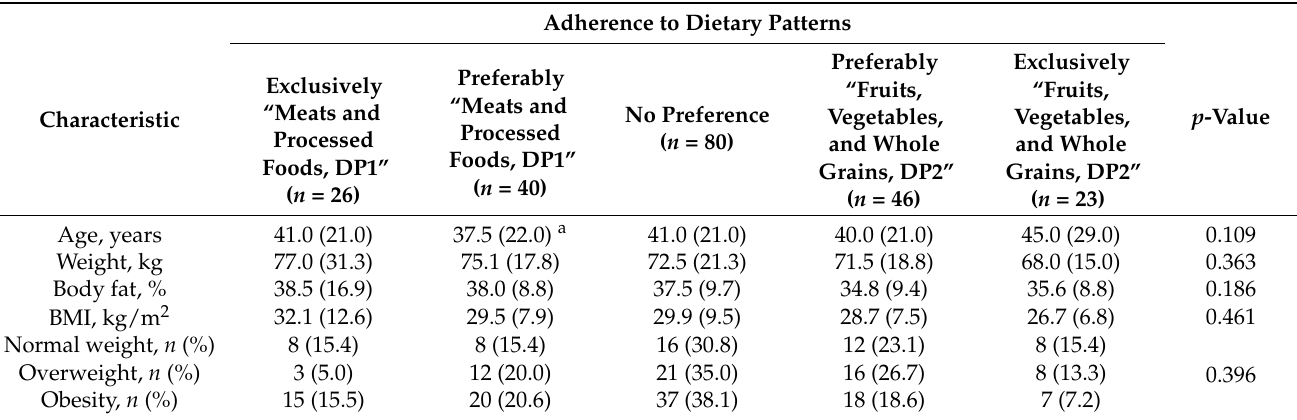
Table 4. Characteristics of 215 Mexican women by adherence to dietary